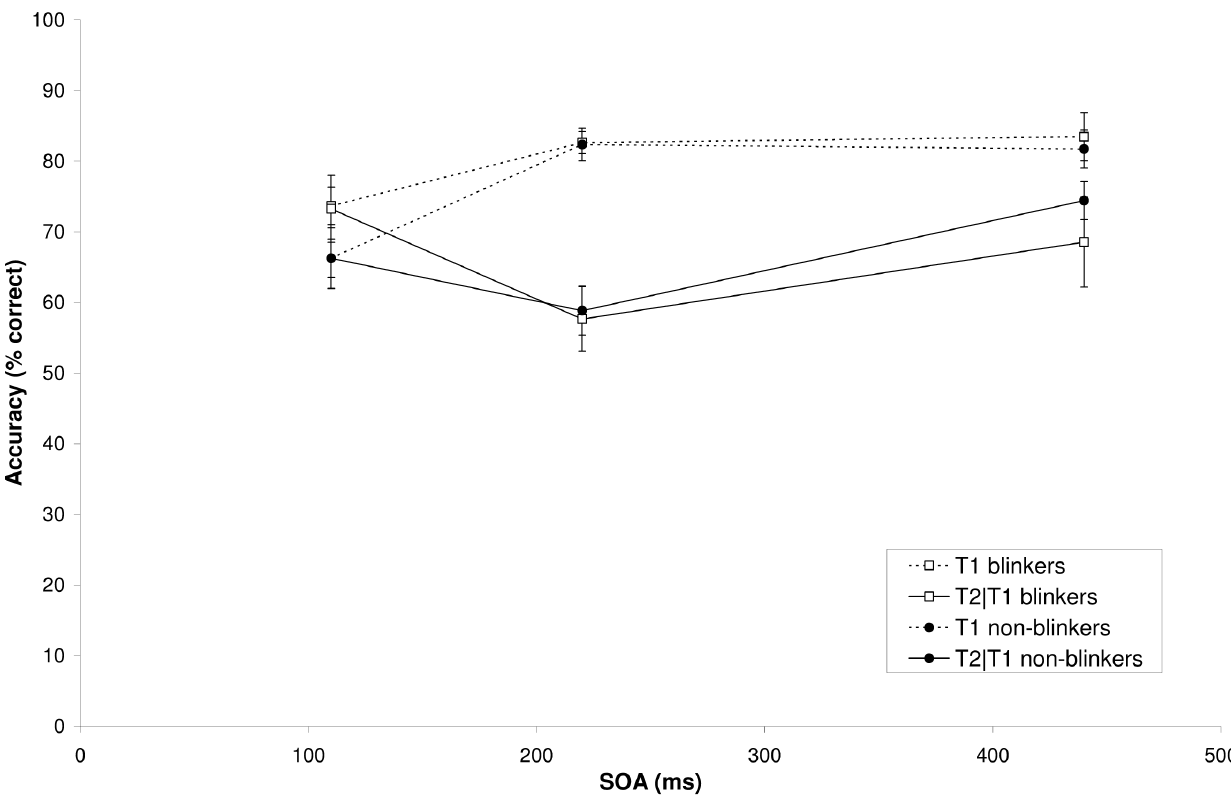
Figure 2. Target accuracy in Experiment 1B. Mean percentage correct report of T1 (dotted lines) and T2 given correct report of T1 (solid lines) as a function of SOA for blinkers (square symbols) and non-blinkers (circle symbols) in the picture AB task of Experiment 1B.